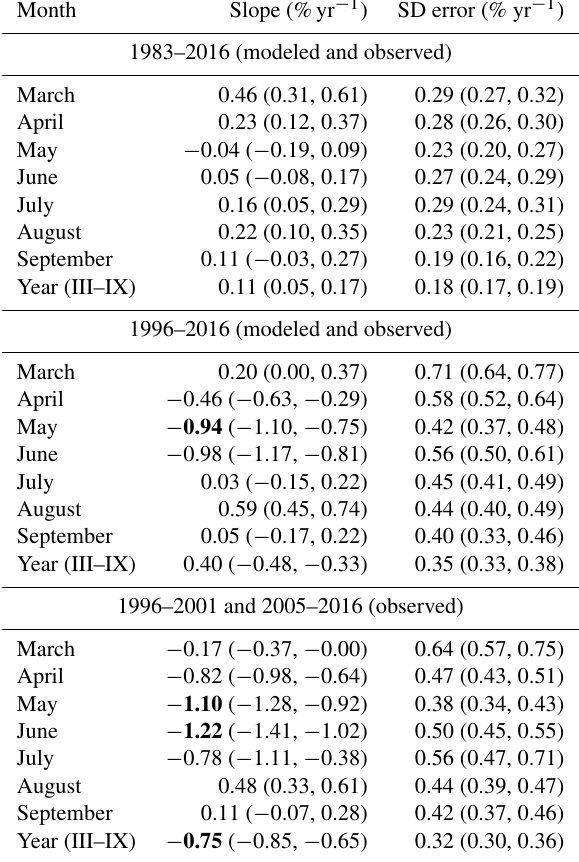
Table 2. The monthly and yearly mean slope of the linear fit and the corresponding standard deviation (in percentage per year) from 10000 samples of the hypothetical time series for the periods 1983– 2016 (modeled and observed data) and 1996–2016 (observed and modeled data), and for the periods 1996–2001 and 2005–2016 (ob- served data only). The minimum and maximum values of the slope and its standard deviation selected from 10000 simulations are in the parentheses. Numbers in bold font represent statistically signif- icant estimates at 2 σ